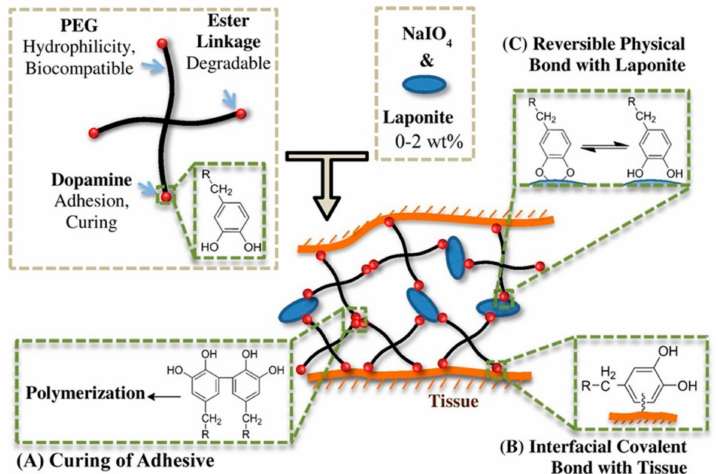
Figure 8. Preparation of nanocomposite hydrogel and proposed three types of cross-links in this system. ( A ) Curing of adhesive. ( B ) Interfacial covalent bond with tissue. ( C ) Reversible physical bond with laponite. Reproduced with permission from Ref. [73], Copyright 2014, American Chemical